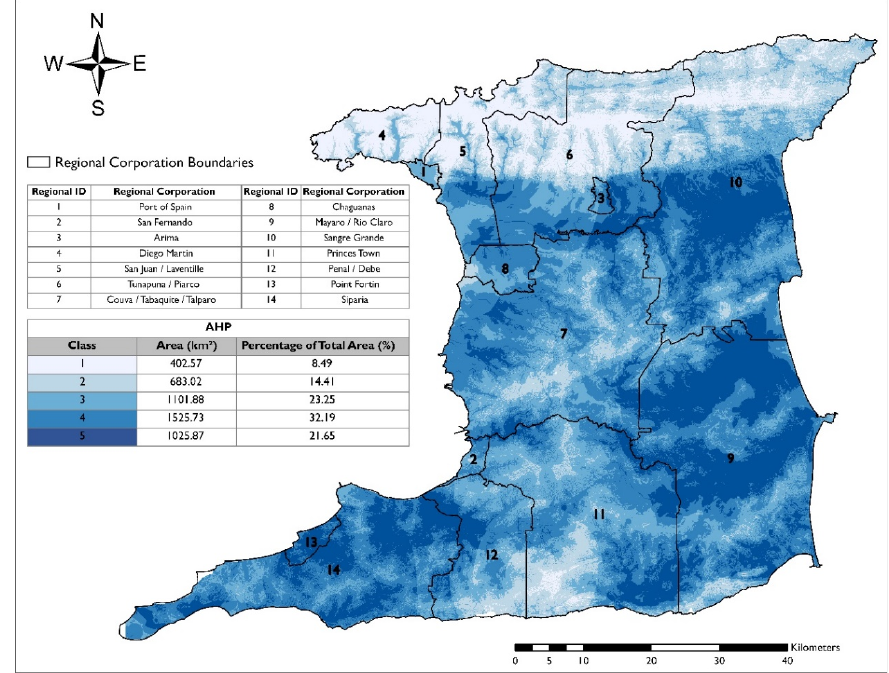
Figure 7. Flood Hazard Indexes created for AHP.